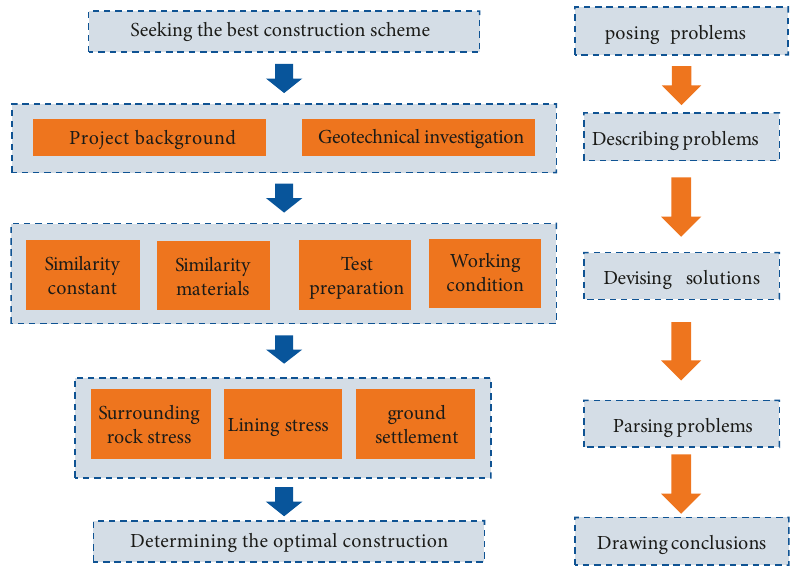
Figure 3: Research Table 1: Similarity ratio of physical quantities.